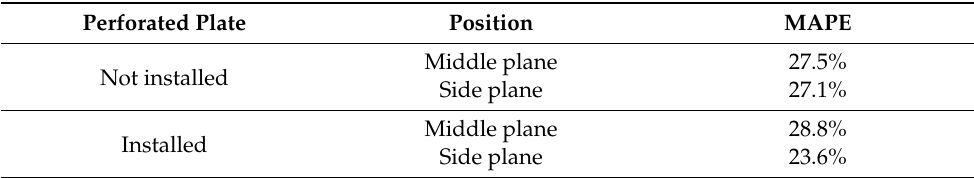
Table 2. Comparison of simulation and experimental velocity profiles.